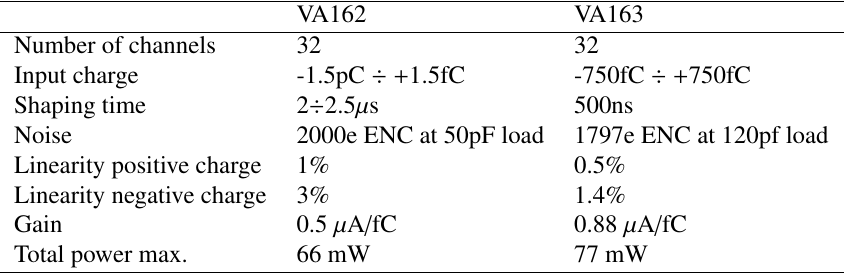
Table 1. VA162 and VA163 characteristics